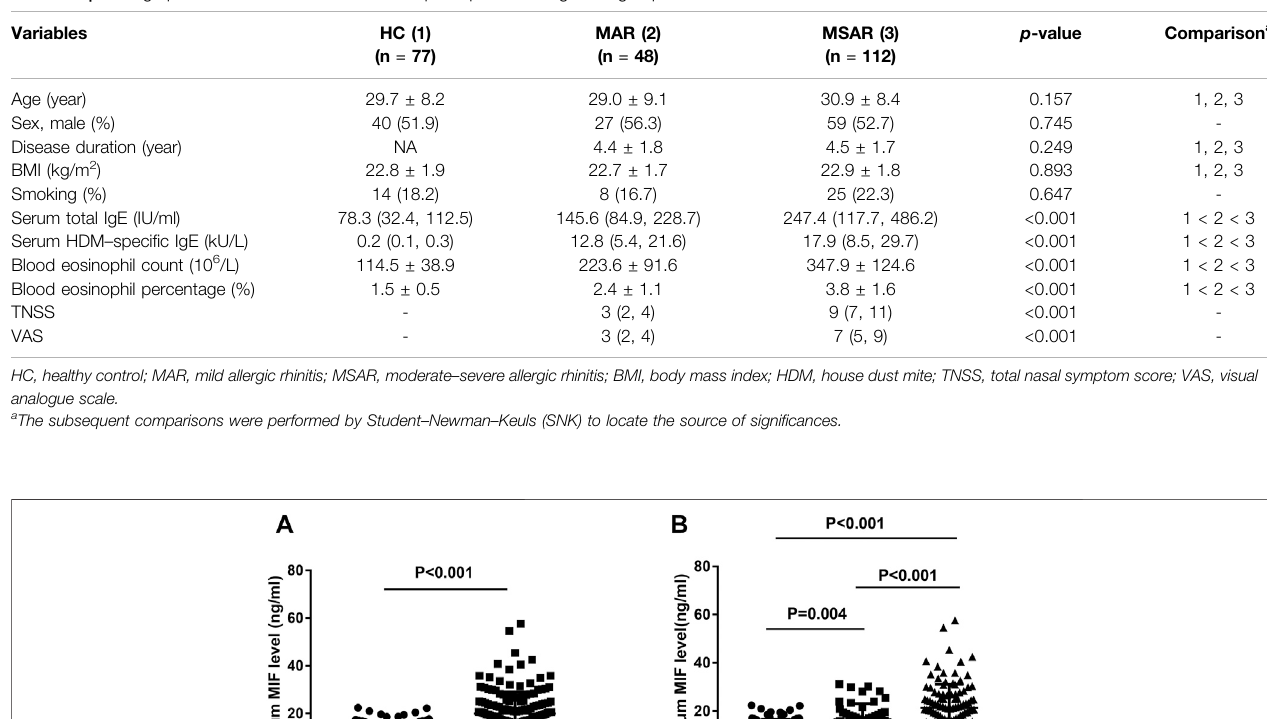
Frontiers in Pharmacology |